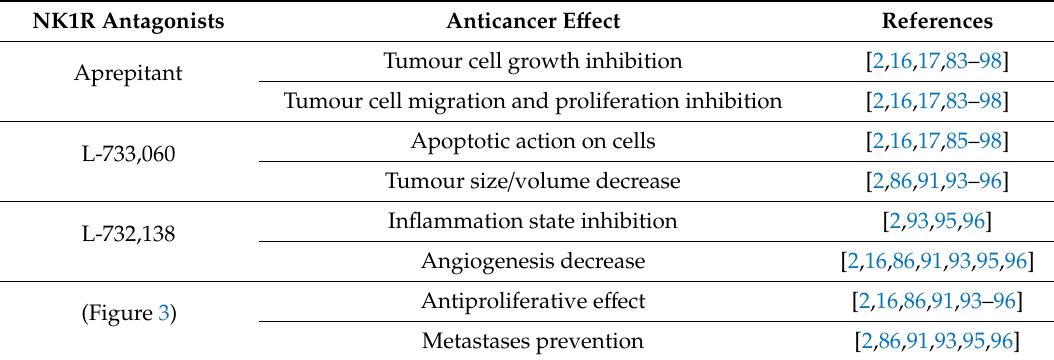
Table 3. Anticancer e ff ects of three most studied NK1R